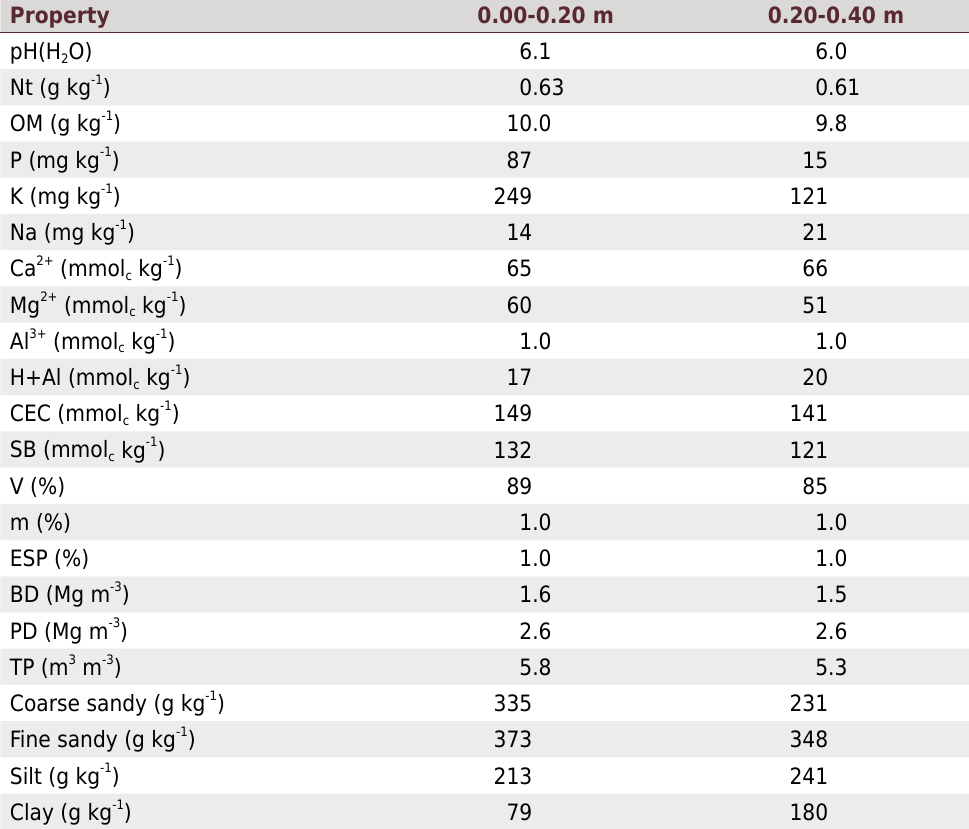
Table1. Chemical and physical properties of the soil in the experimental area